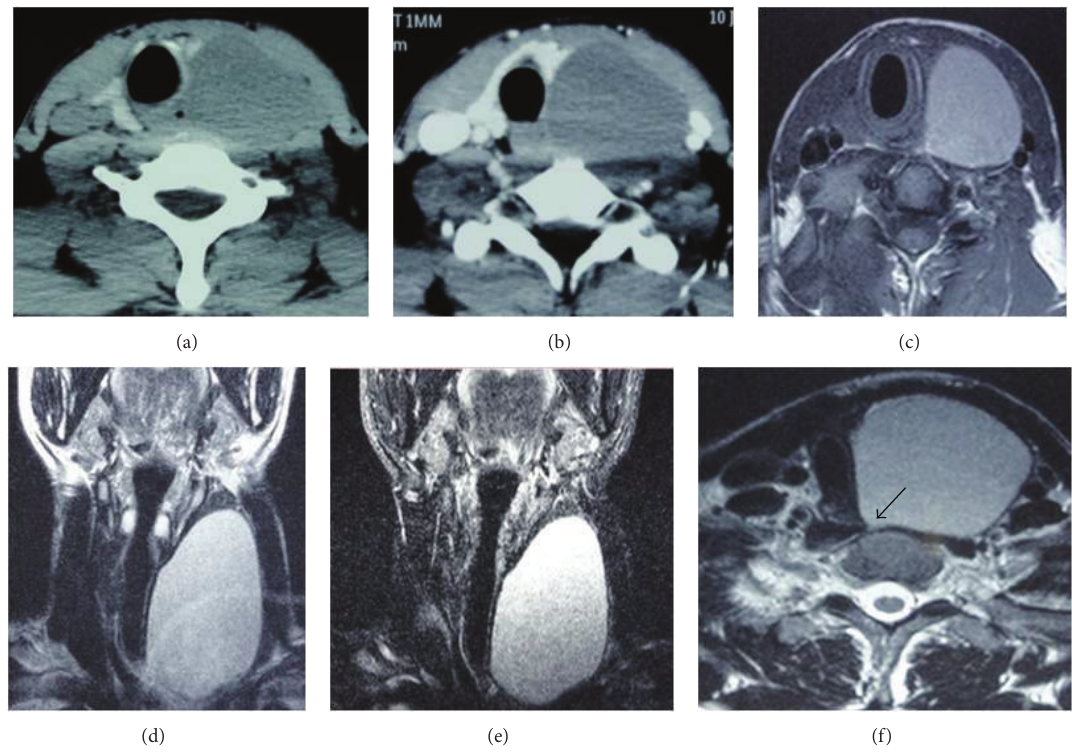
Figure 2: Plain (a) and contrast (b) axial images of computed tomography (CT) revealing isodense nonenhancing neck swelling. Axial images of T1 (c), T2 (f) weighted sequence, coronal images of T2 weighted (d), and fat saturation (e) sequences of magnetic resonance imaging (MRI) showing lesion to be hyperintense. On T2 weighted axial image, the lesion had a small beak-like extension ((black arrow in (f)).